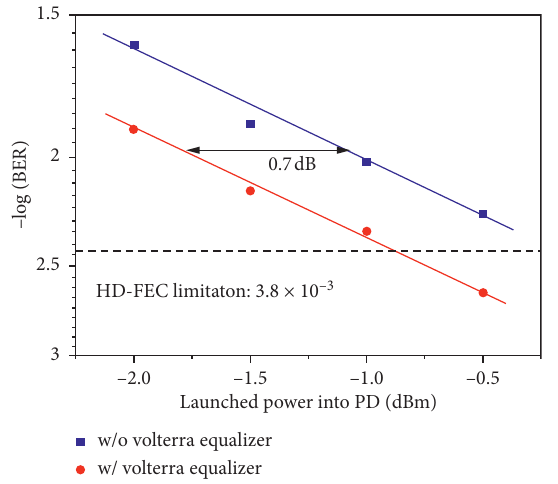
Figure 6: BER curves of the OFDM signal with and without the Volterra nonlinear